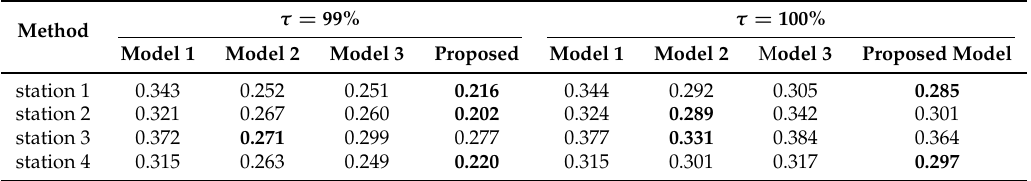
Table 3. Performance comparison of the methods under 99%/100%